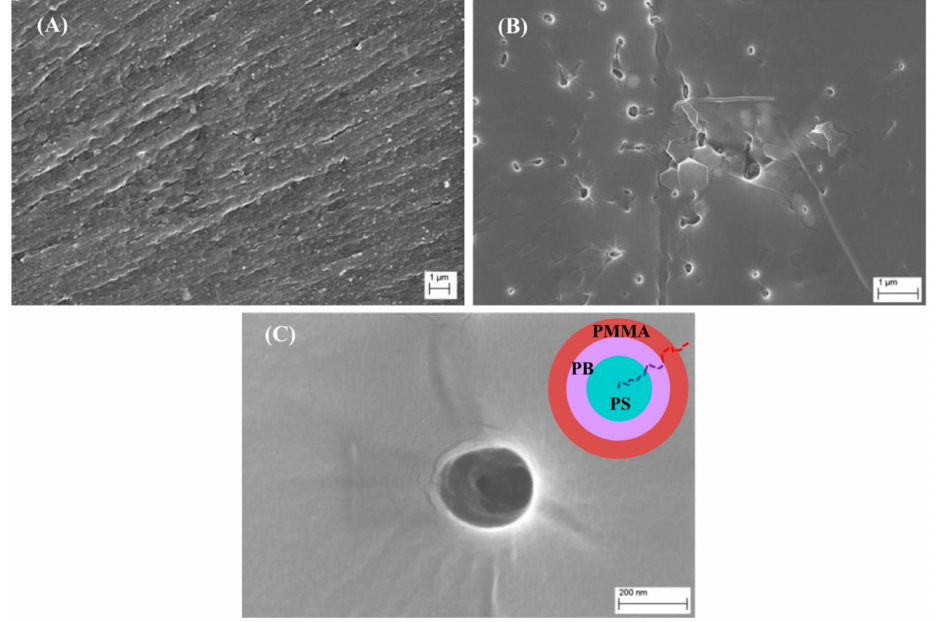
Figure 14. Representative FESEM images of neat ( A ) and toughened K3600 ( B , C ) resin samples produced by brittle fracture. The insert in ( C ) shows proposed structuring of the spherical micelle identified in these micrographs and an example copolymer chain from this